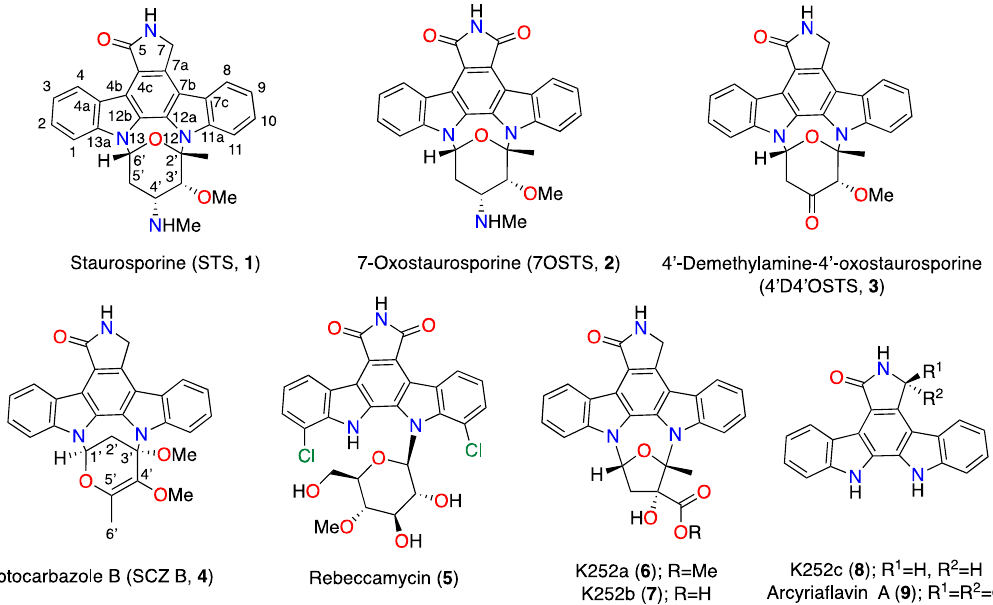
Figure 1. Structures of natural ( 1 – 4 ) and commercial ( 5 – 9 ) idolocarbozoles